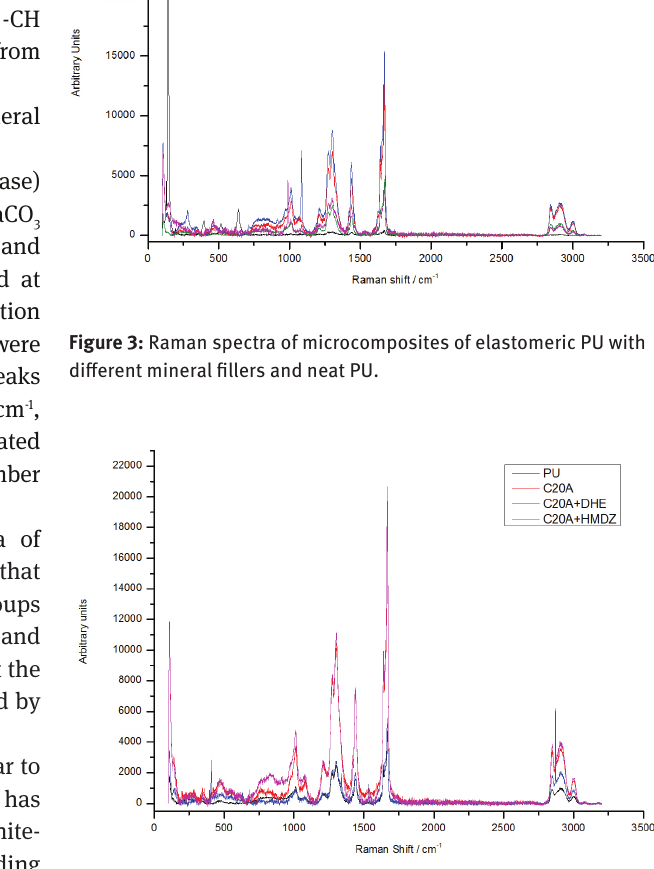
Figure 4: Raman spectra of nanocomposites (NPU) of elastomeric PU with nanoclay and modified nanoclay. PU: neat sample without nanoclay; NPU with C20A 5%; NPU with C20A + HMDS and NPU with C20A+Dantocol